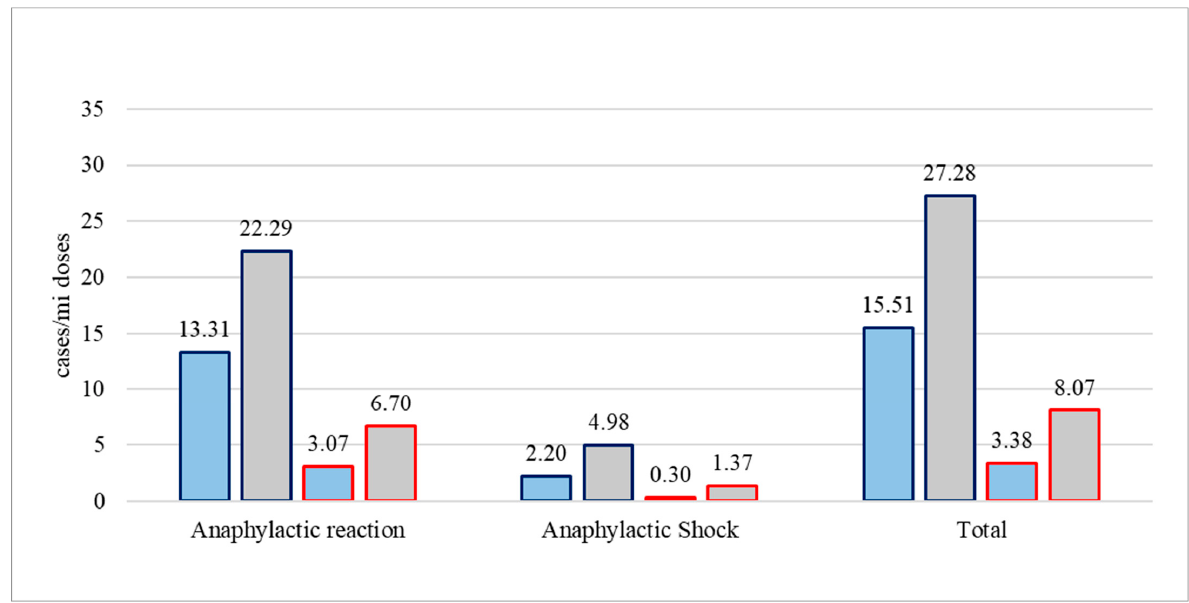
Figure 2. Rates of estimated anaphylactic reaction and anaphylactic shock post-COVID-19- vaccination for mRNA (blue bars) or vectored (grey bars) vaccines, as reported by the EudraVigilance (dark blue lining) and VAERS (red lining) databases, expressed per million administered doses from week 52, 2020 to week 2, 2023 for EudraVigilance and week 1, 2023 for VAERS.